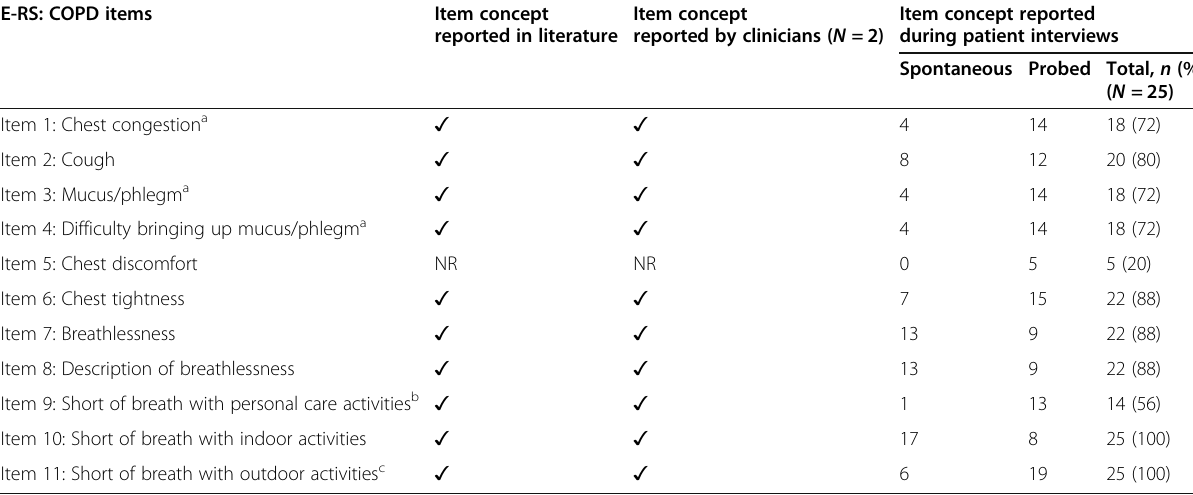
Table 2 Item concepts mapped to E-RS: COPD and supplemental items in the qualitative study E-RS: COPD items Item concept